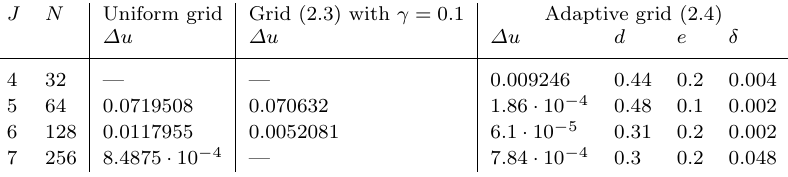
Table 6. Maximal deviation from the exact solution ∆u against resolution J in the case of the mKdV equation with α = 1, β = 10 − 2 , c = 16 and x 0 = 0 . 3, t f = 1 / 40. J N Uniform grid Grid (2.3) with γ = 0 . 1 Adaptive grid (2.4) ∆u